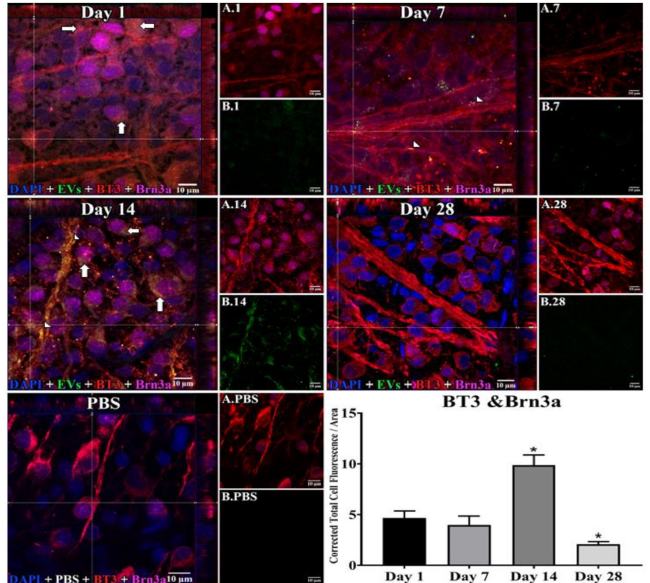
Figure 1. Staining for Extracellular Vesicles (EVs) in retinal ganglion cells (RGCs) in flat mounts of rat retinas. The results show that EV staining in RGCs peaks at 14 days after intravitreal injection of EVs. Fluorescent colors are as follows: anti- β -tubulinIII (BT3, red), anti-Brn3a (magenta), EVs (green), DAPI (blue). Orthogonal 3D projection shown as a composite for each day’s panel, and red and magenta channels (A.1, A.7, A.14, A.28) and green channels (B.1, B.7, B.14, B.28) for a representative z-stack alongside each day’s composite. PBS injected control is bottom left; A.PBS is red and magenta channels, and B.PBS is green channel. Scale bars (10 µ m) are on the bottom right of each panel. Arrows = overlap (co-localization, yellow or yellow-orange) of green EVs and anti- β -tubulinIII in Brn3a-containing RGCs. Arrowheads = co-localization of BT3 and EVs in neural projections from RGCs. 100x. Bottom right: graph of green fluorescence intensity (Y axis), expressed relative to background. N = 4 per time point * p < 0.05 vs. day